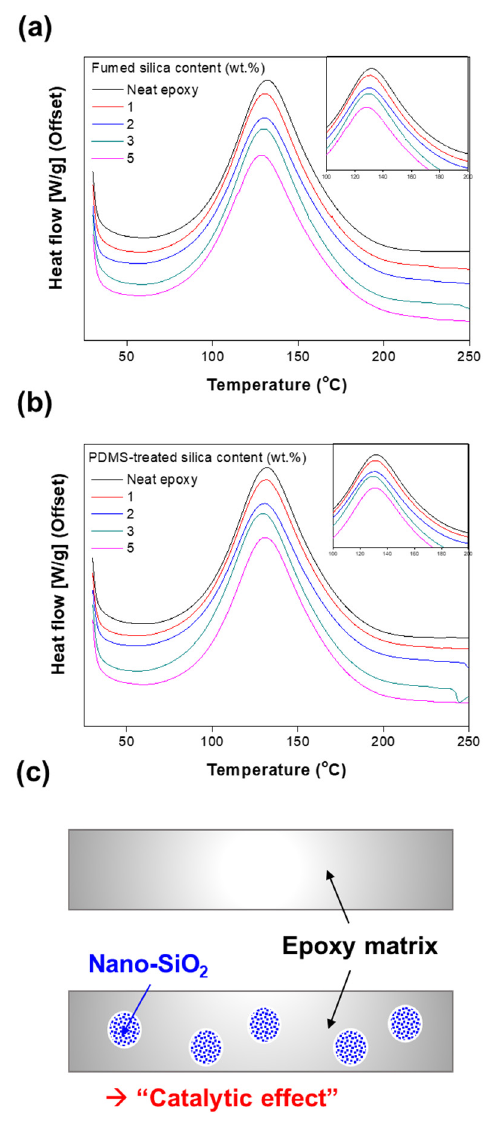
Figure 2. DSC curves of epoxy nanocomposites with ( a ) fumed silica and ( b ) PDMS-treated fumed silica. ( c ) Schematic of the catalytic effect.